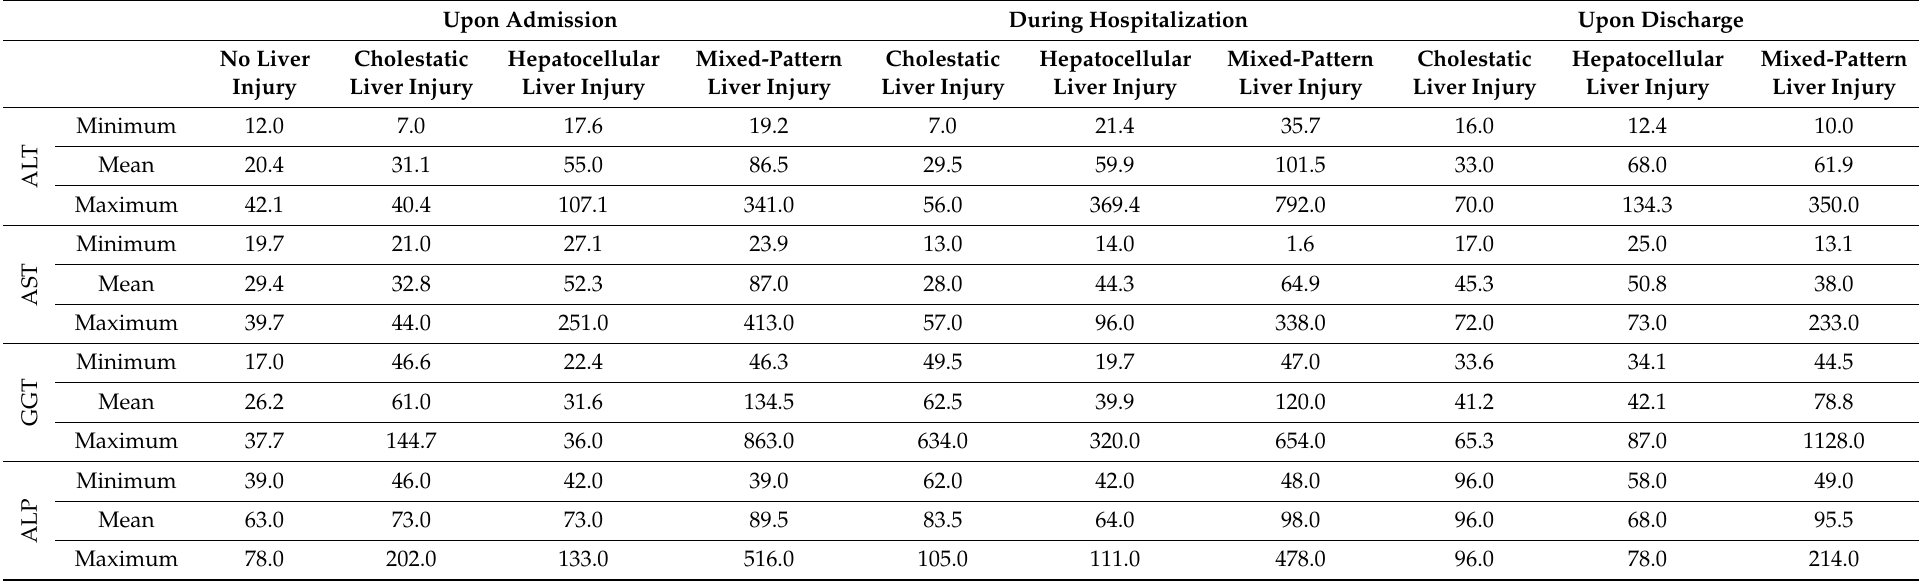
Table 2. Liver function tests in patients with liver injury upon admission, during hospitalization and, upon discharge.